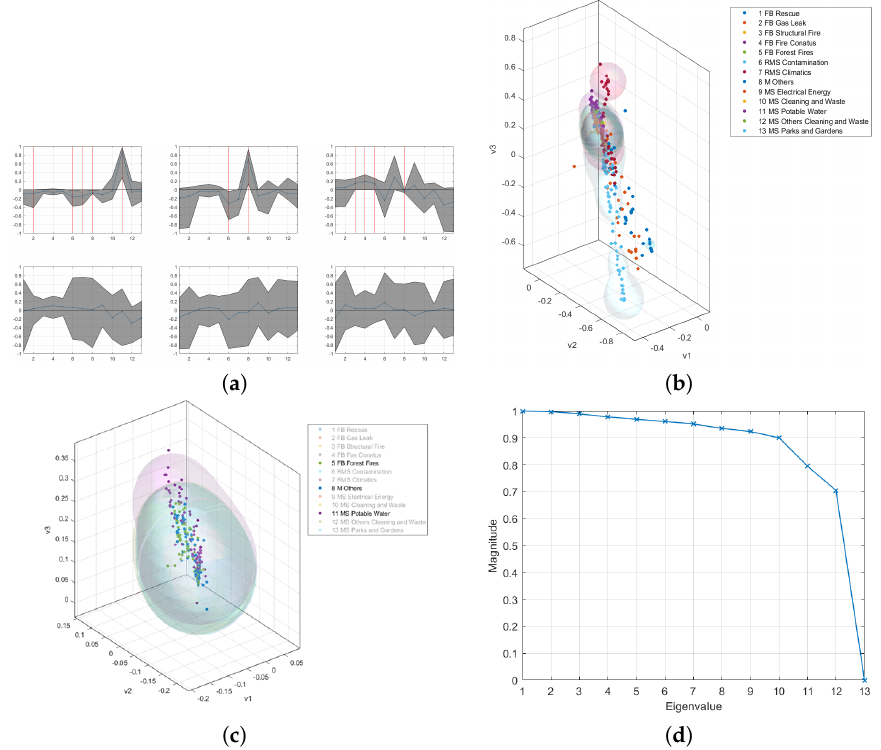
Figure 10. Categories of fire brigades, risk management secretary, military, and municipal services. ( a ) Eigenvalues of the FRIs analyzed, according to the selection criteria, none of the dimensions are used to describe this group of categories. ( b ) All the categories plotted together. ( c ) Events concentrations of three FRIs, when a forest fire overpasses the capacity of fire brigades, then military forces move personnel, vehicles, or aircraft, and municipal services coordinate the water supply for helicopters and tank trucks. ( d ) The eigenvalues plot shows us the relative relevance of each dimension in